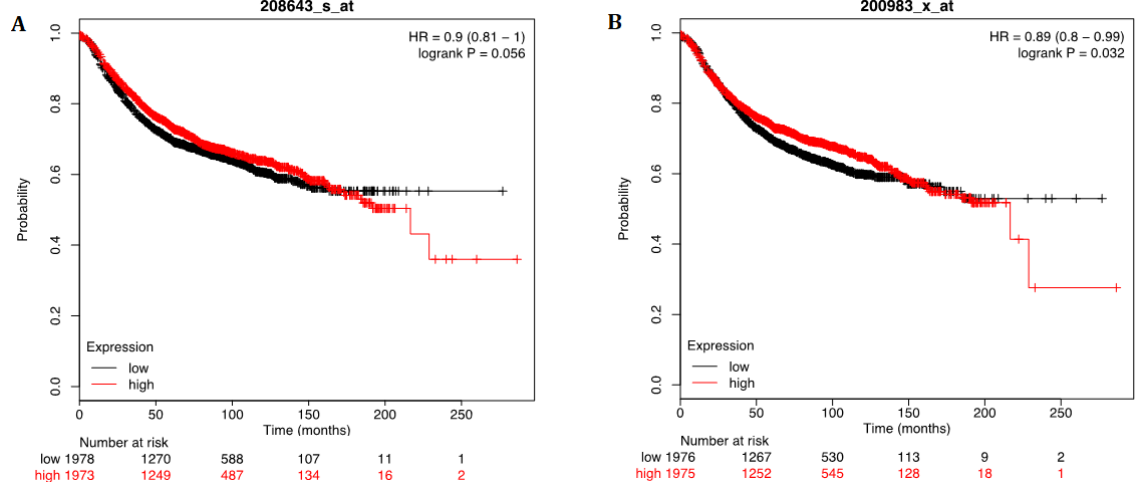
Figure 4. Kaplan–Meier survival curves for (A) XRCC5 and (B) CD59 , as analyzed by